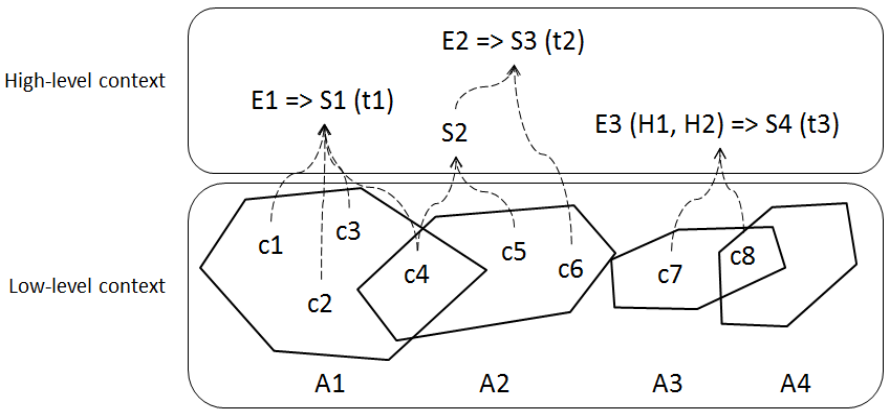
Figure 1. Context and